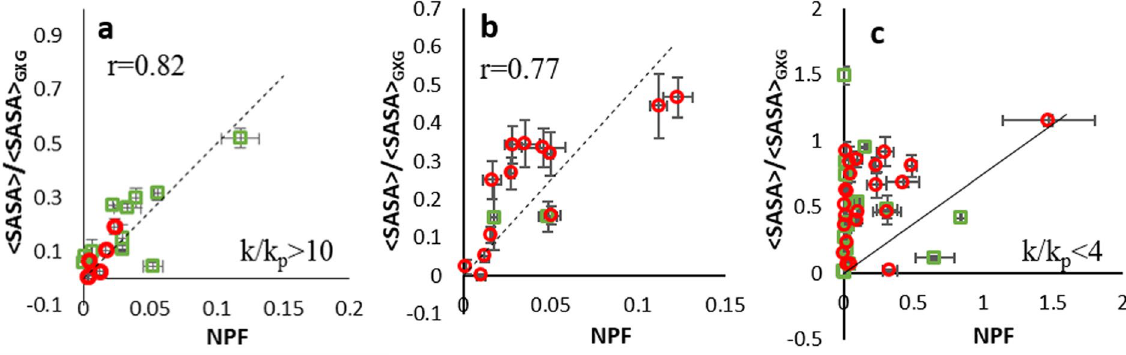
Figure 2. Correlation plots of NPF (the slope of the linear regression divided by the inherent reactivity of the free amino acid) vs. fractional < SASA > ( < SASA > of the amino acid in the folded structure divided by the < SASA > for that same amino acid in a Gly-X-Gly tripeptide) for amino acids identified to be oxidized from lysozyme (green square) and myoglobin (red circle) sample for: ( a ) amino acids with high inherent reactivity ( > 10x more reactive than Pro); ( b ) amino acids with moderate inherent reactivity (4–10x more reactive than Pro); ( c ) amino acids with poor inherent reactivity ( < 4x more reactive than Pro). All data shown from triplicate experiments using mean ± SD plotted for all data (x-axis error bars), with fractional < SASA > from MD simulation of the protein structure ± SD from the MD trajectory (y-axis error bars).